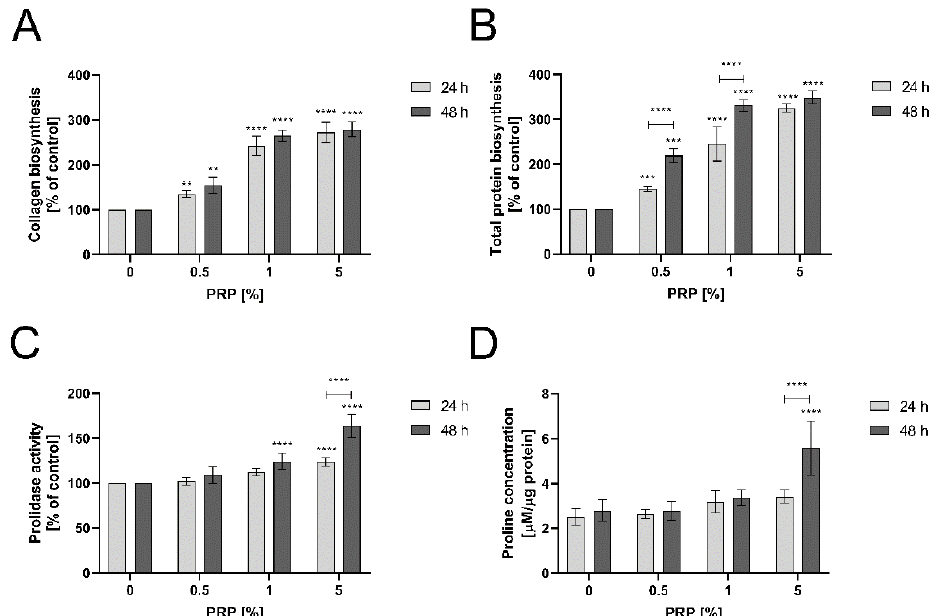
Figure 6. PRP stimulates collagen biosynthesis through enhancing prolidase activity and proline availability ( A ) Increased collagen biosynthesis under PRP treatment in HaCaT cells after 24 and 48 h; ( B ) Total protein biosynthesis used for normalization of collagen biosynthesis; ( C ) Prolidase activity in keratinocytes upon 24 and 48 h PRP treatment; ( D ) Proline concentration in keratinocytes treated with PRP for 24 and 48 h. Statistical significances were expressed using asterisks such as ** <0.01, *** <0.001 and **** <0.0001.